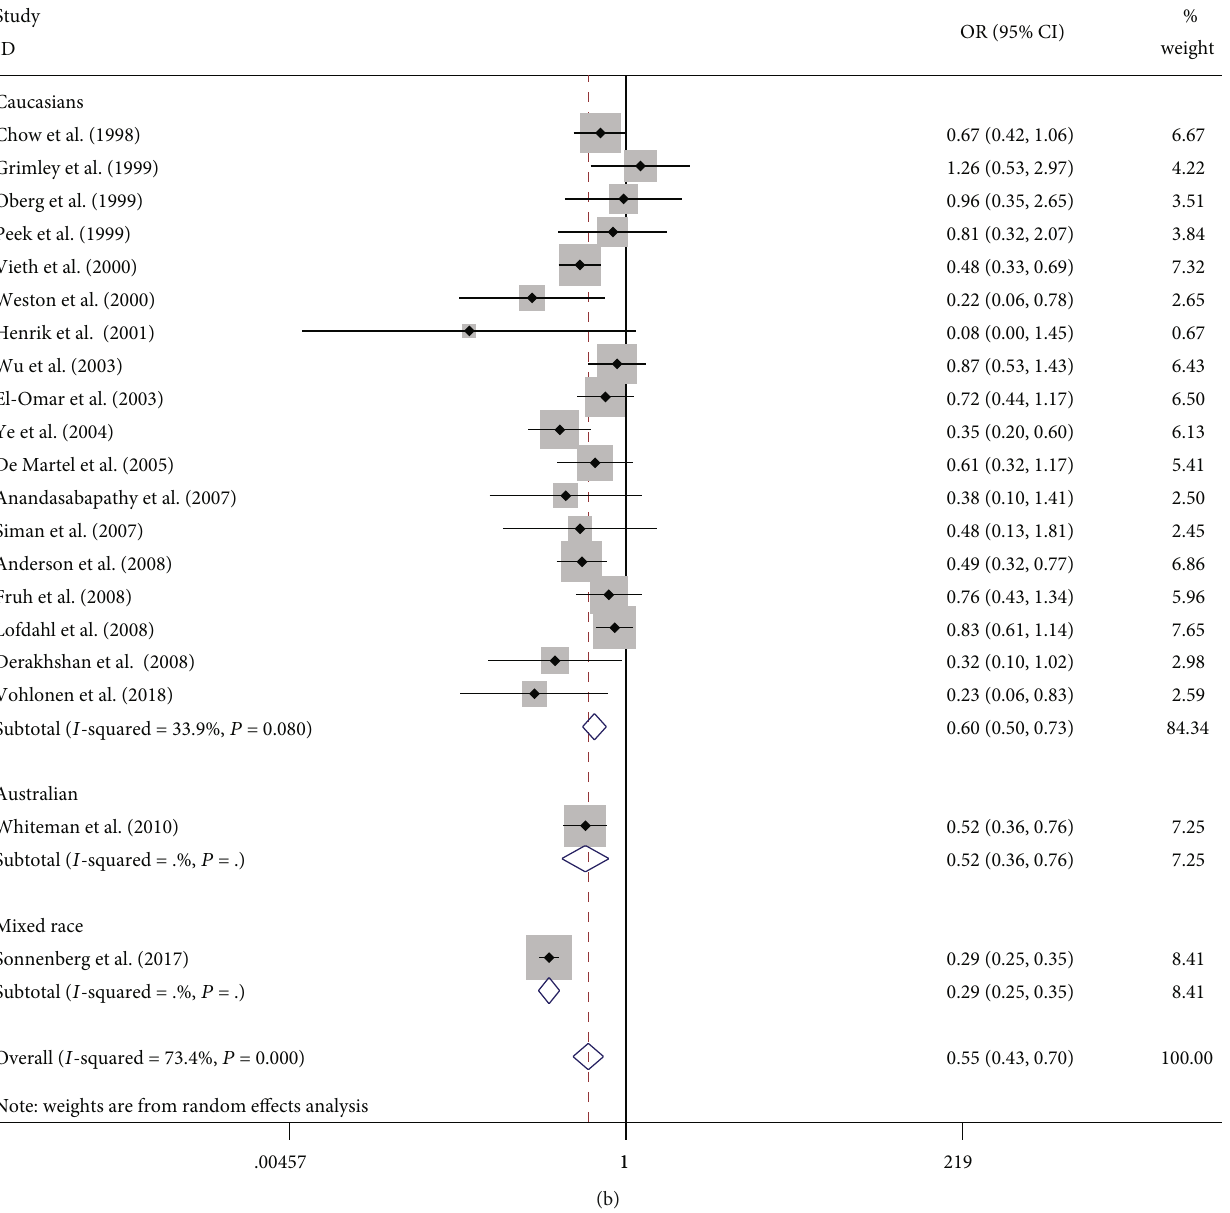
Figure 2: Meta-analysis of the association between Helicobacter pylori infection and esophageal cancer after grouping based on ethnicity: (a) forest plot of esophageal squamous cell carcinoma; (b) forest plot of esophageal adenocarcinoma. Each horizontal bar summarizes a study. Bars represent 95% CIs. Gray squares inform on each of the studies ’ weight in the meta-analysis. Diamond in the lower part of the graph depicts the pooled estimate along with 95%